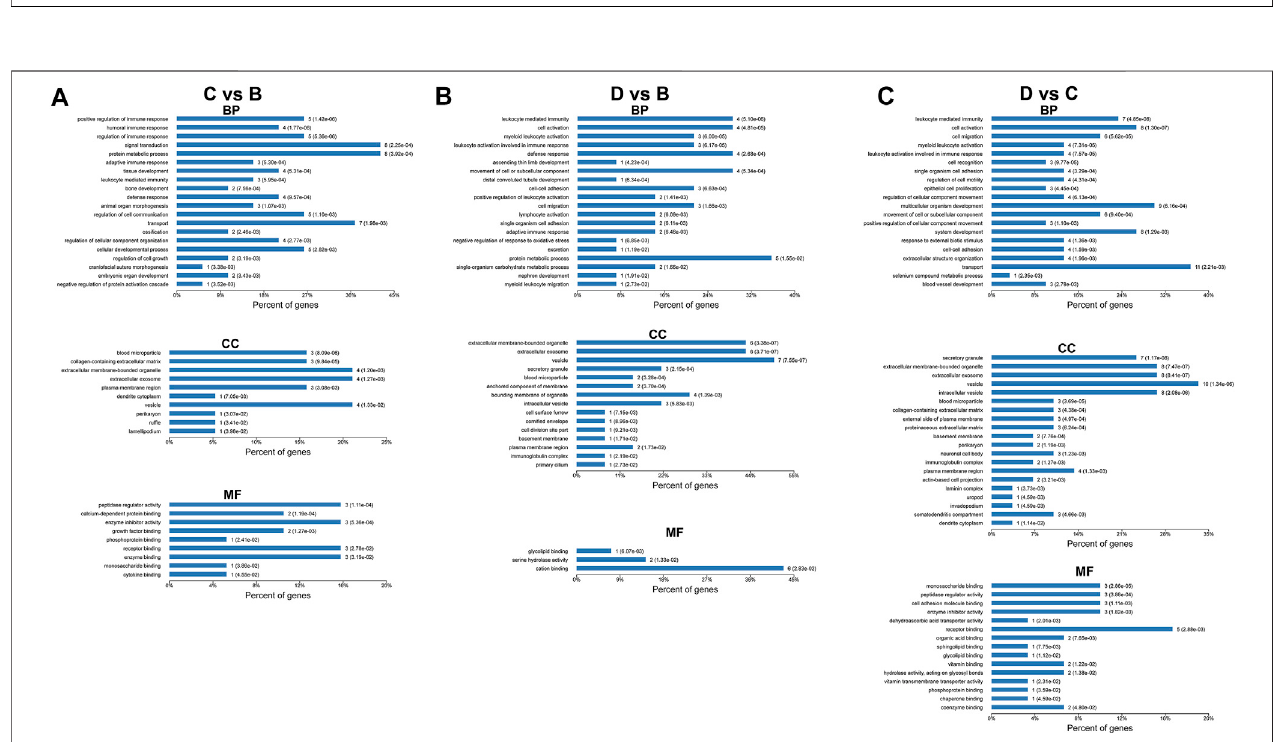
FIGURE 6 | GO enrichment analysis of differentially expressed proteins: (A) group C (moderate OSA) vs group B (mild OSA), (B) group D (severe OSA) vs group B (mild OSA), and (C) group D (severe OSA) vs group C (moderate OSA).